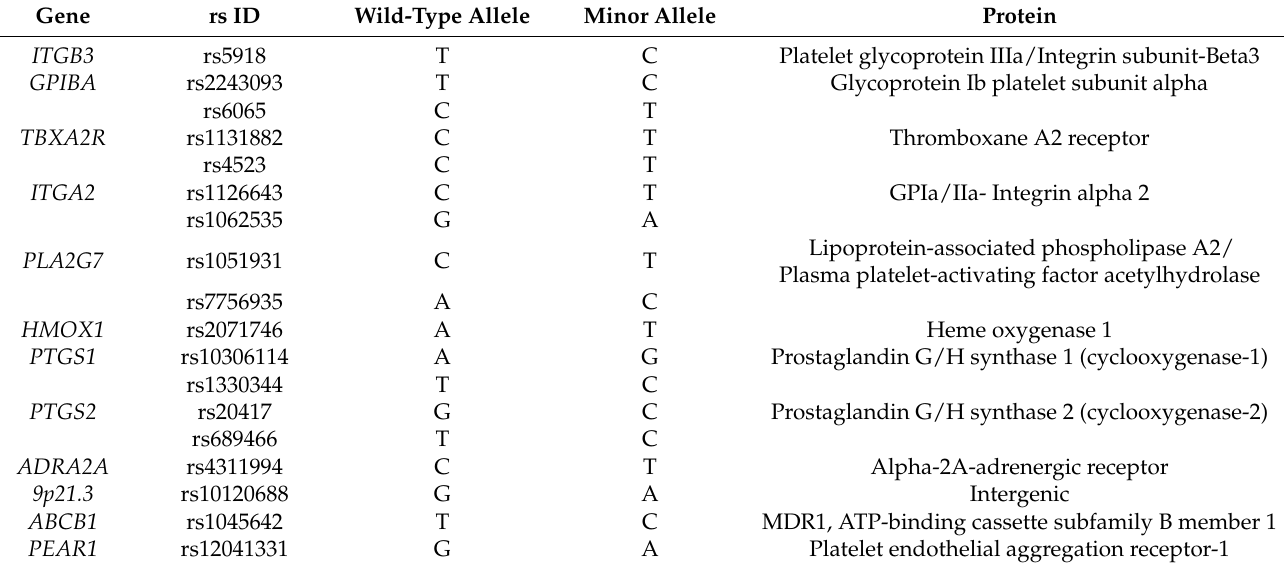
Table 1. A list of studied genetic